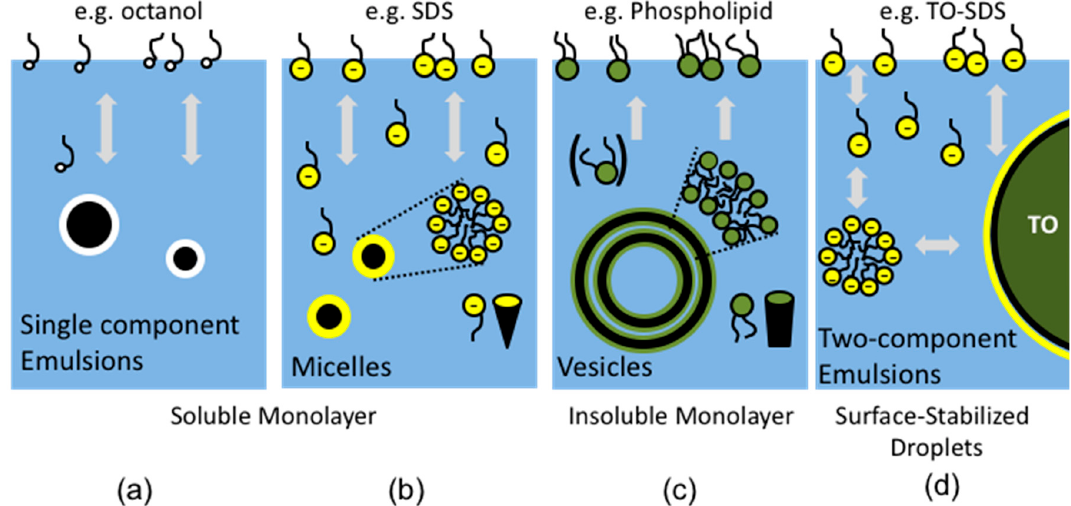
Figure 11. Surface active compounds at the air-water surface and in bulk aqueous phase. ( a ) Soluble Monolayer: Long-chain alcohols, such as Octanol, can spread at the air-water (blue background) surface to make a soluble monolayer (monomer can transfer between monolayer and bulk). The monolayer has a certain orientation, i.e., hydrophilic OH-headgroup (white circle) towards the water and hydrophobic C8 alkyl chain (black curvy line) towards the air. Above its solubility limit in bulk aqueous solution, octanol can behave like pure hydrophobic oil, i.e., forming its own oil emulsion with octanol also adsorbed at this interface. ( b ) Soluble Monolayer: Detergents, such as the anionic sodium dodecyl sulphate (SDS), can spread at the air-water surface to form a soluble monolayer. The orientation is the same as the long-chain alcohol with the negatively charged hydrophilic polar group facing the aqueous phase, (yellow circle) and the hydrophobic C12 alkyl chain towards the air (black curvy line). Above its solubility limit in bulk, monomers form micelles. ( c ) Insoluble Monolayer: Lipids, such as phospholipids, can spread at the air-water surface to form an insoluble monolayer, again with headgroups in the water phase (green circles) and double acyl chains in air (double black curvy lines), with relatively little molecular lipid (bracketed) in solution (water solubility, S w ~10 nM or less). In the bulk aqueous phase monomer lipids self-assemble into vesicles. ( d ) Surface-Stabilised-Droplets. Micro- or nano-emulsion droplets can be stabilised with, for example, the anionic detergent SDS.